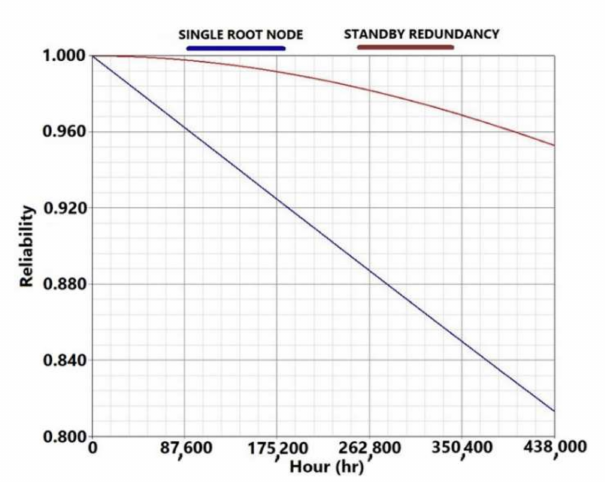
Figure 10. Reliability trends of the network under test obtained using the territory-based model by means of Fault Tree Analysis. The blue line stands for the reliability without standby redundancy, while the red line represents the reliability considering the standby redundancy of the root